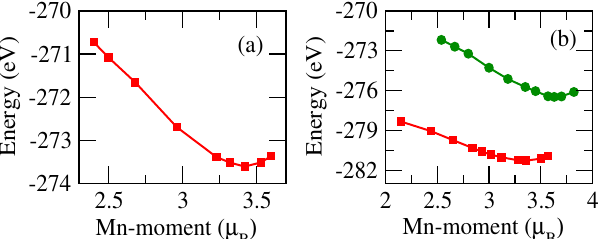
Figure 4. Variation of the total energy with the fixed local Mn moment for ( a ) ThMnAsN and ( b ) ThMnPN (green circles indicate the variation of the total energy with the fixed Mn magnetic moment with an effective Hubbard U of 0.9 eV) with the C-AFM spin